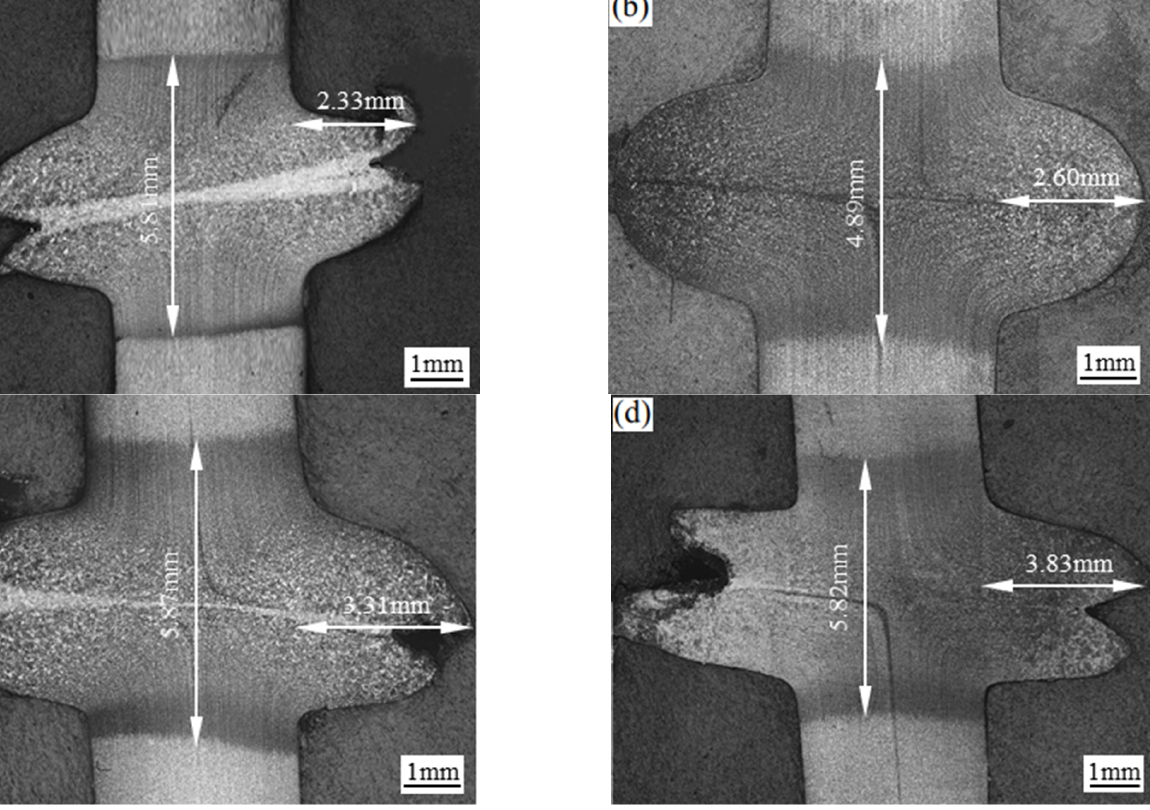
Figure 2. The residual height and HAZ width of the joint under different upset current. ( a ) 42°; ( b ) 44°; ( c ) 46°; ( d ) 48°.